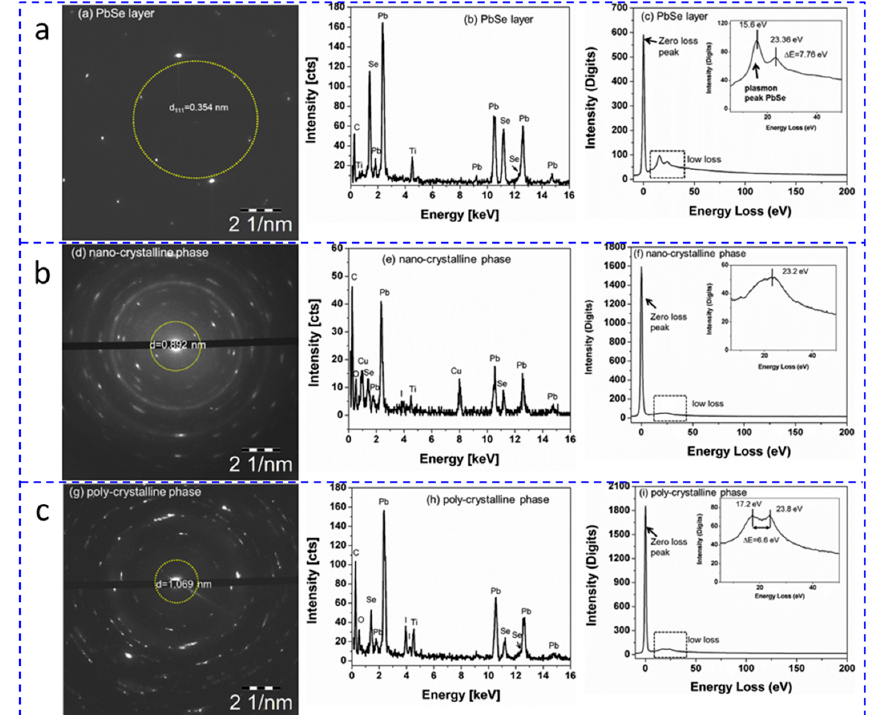
Figure 9. Selected area electron diffraction patterns (SAED) patterns, energy-dispersive X-ray spectroscopy (EDX) spectra, and electron energy-loss spectroscopy (EELS) spectra of ( a ) PbSe bottom layer, ( b ) a nanocrystalline phase of the top layer with the largest d spacing of 0.892 nm, and ( c ) a polycrystalline phase of the top layer with the largest d spacing of 1.069 nm. Reprinted with permission from [78]. Copyright Elsevier 2017.